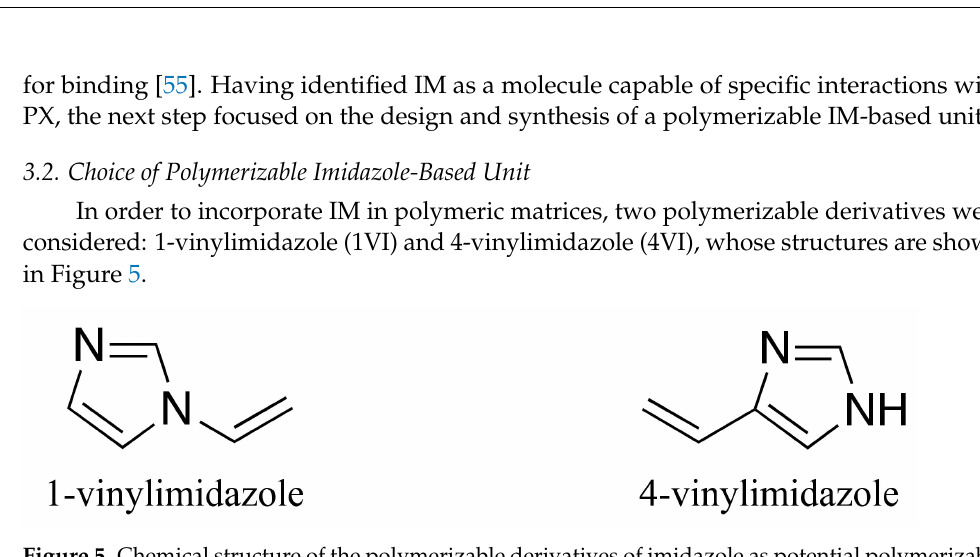
Figure 5. Chemical structure of the polymerizable derivatives of imidazole as potential polymerizable monomers, 1- and